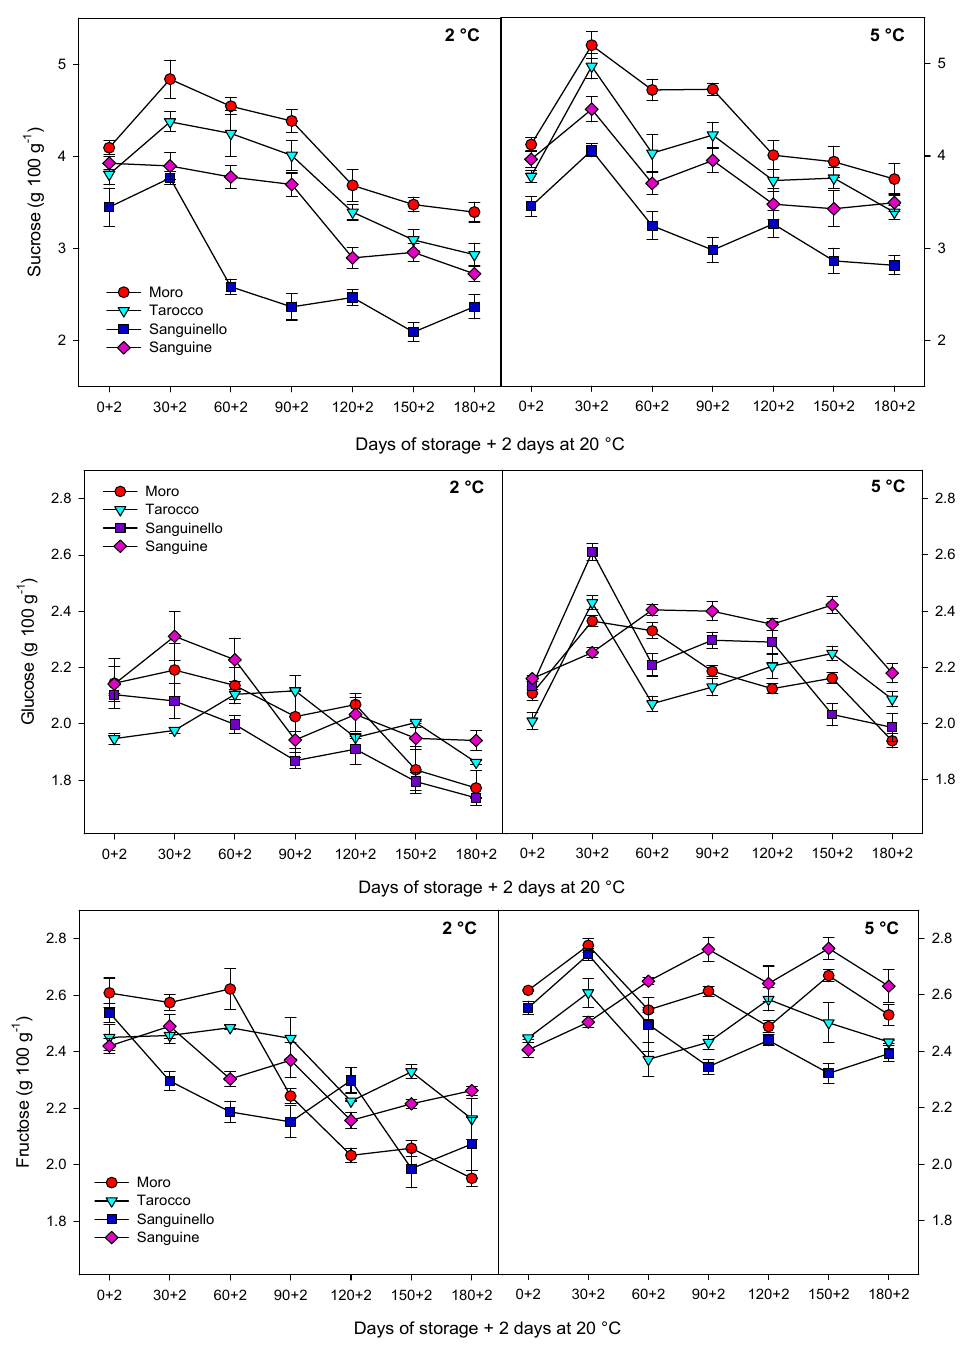
Figure 1. Changes in individual sugars sucrose, glucose, and fructose of blood orange cultivars (“Moro”, “Tarocco”, “Sanguinello”, and “Sanguine”) stored at 2 and 5 ◦ C for 180 days plus 2 days at 20 ◦ C. Vertical bars represent ± standard error (SE) of means. Least significant di ff erence (LSD, p < 0.05) values are 0.41, 0.21, and 0.37, for sucrose, glucose, and fructose,